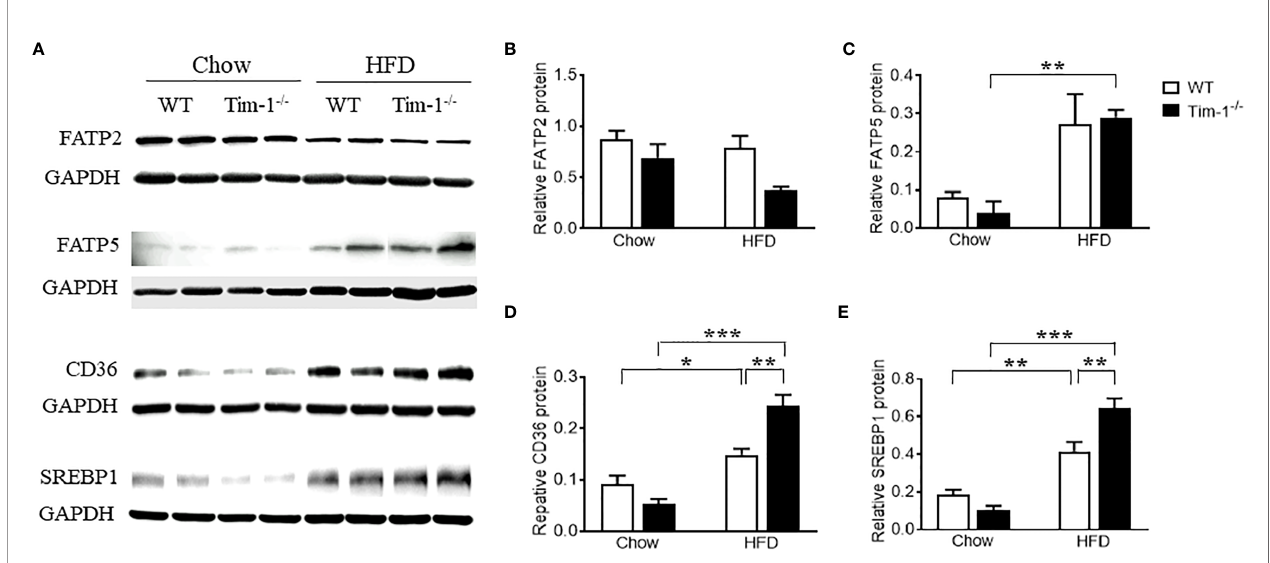
FIGURE 4 | Tim-1 de fi ciency increased protein levels of FATP5, CD36 and SREBP1 in HFD mouse livers. (A) Representative Western blot images of FATP2, FATP5, CD36, and SREBP1 in the liver of chow or HFD-fed WT and Tim-1 -/- mice. (B – E) Quantitative analysis of each protein. Values are mean ± SEM. n=4-6 mice. Statistical differences were assessed by one-way ANOVA with Tukey ’ s multiple comparisons test; * P <0.05, ** P <0.01, *** P